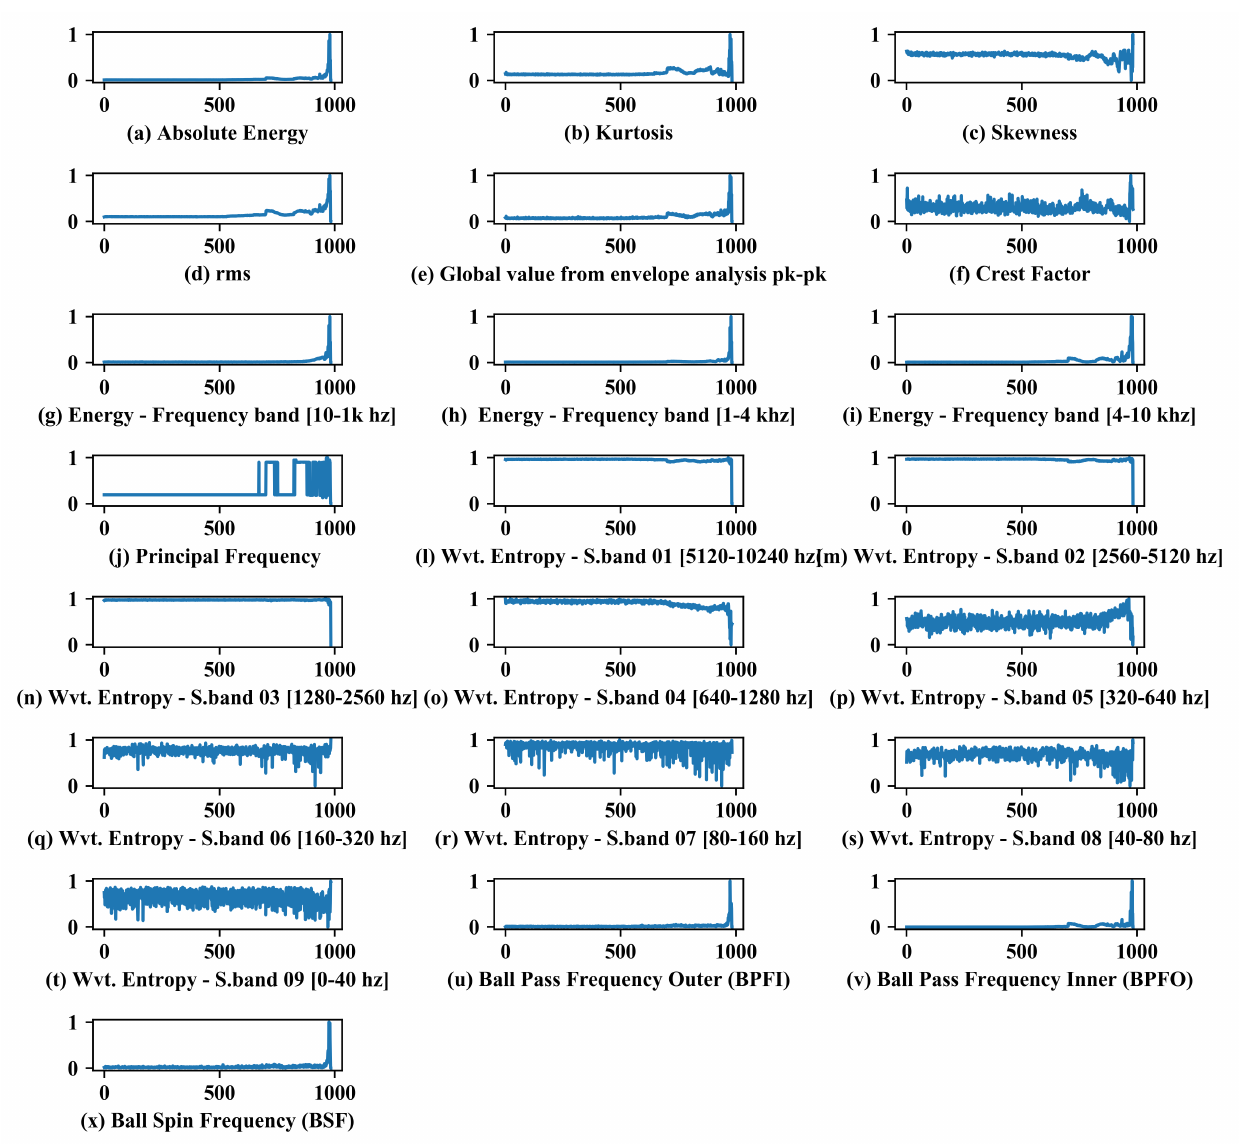
Figure 7. Trend analysis and behavior of extracted features during testing.